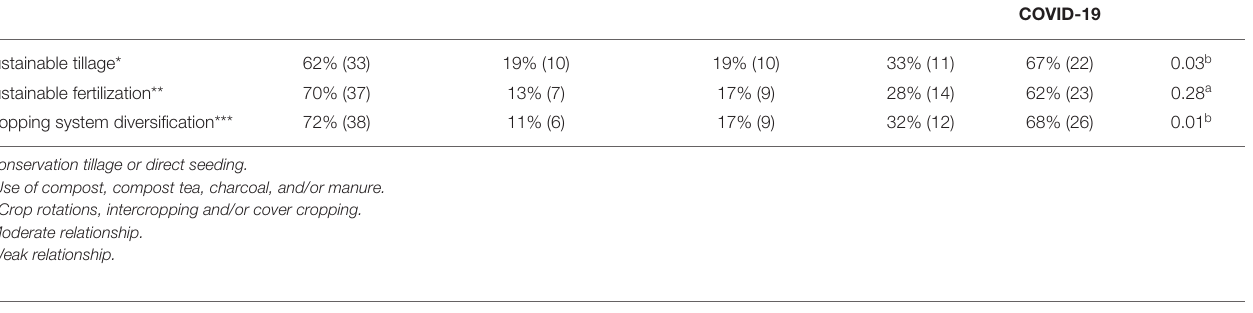
TABLE 6 | Crop choice changes due to COVID-19 in the 2020 and 2021 cropping season, based on farming practices applied by surveyed producers. Farming